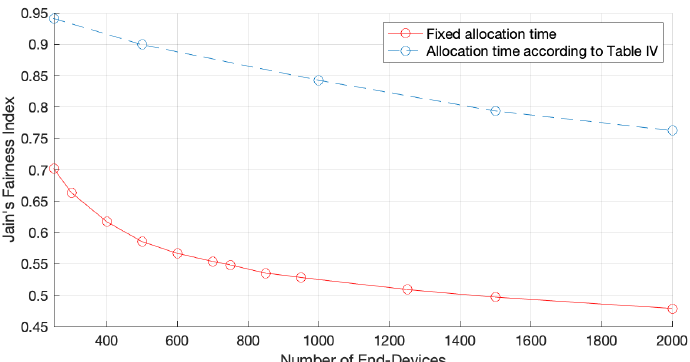
Figure 10. Network fairness for one GW and fair channel allocation times.